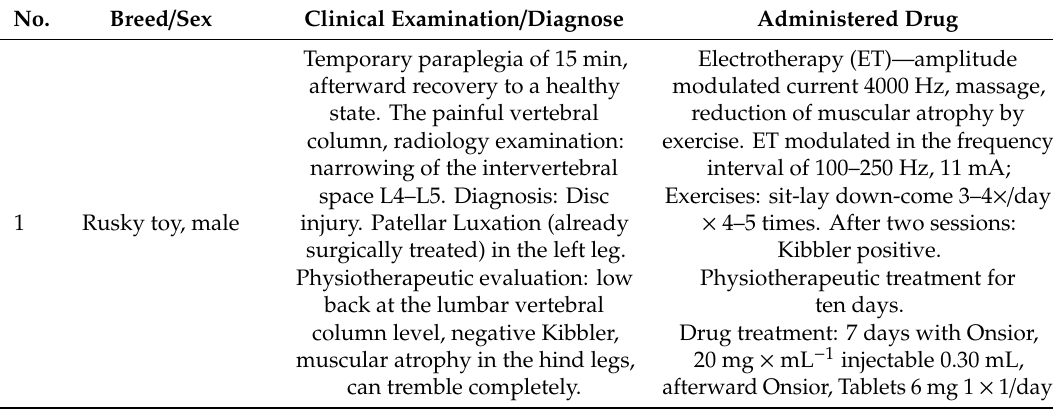
Table 3. Physiotherapy protocol